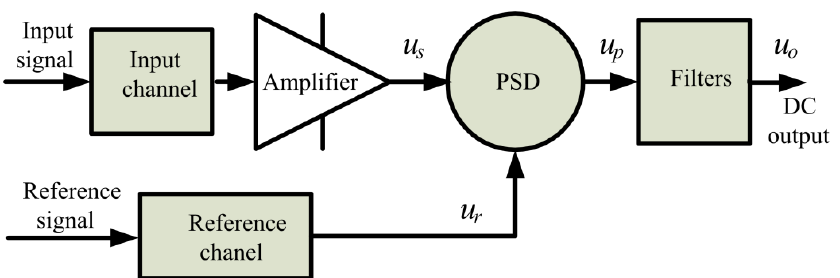
Figure 10. Lock-in amplifier block